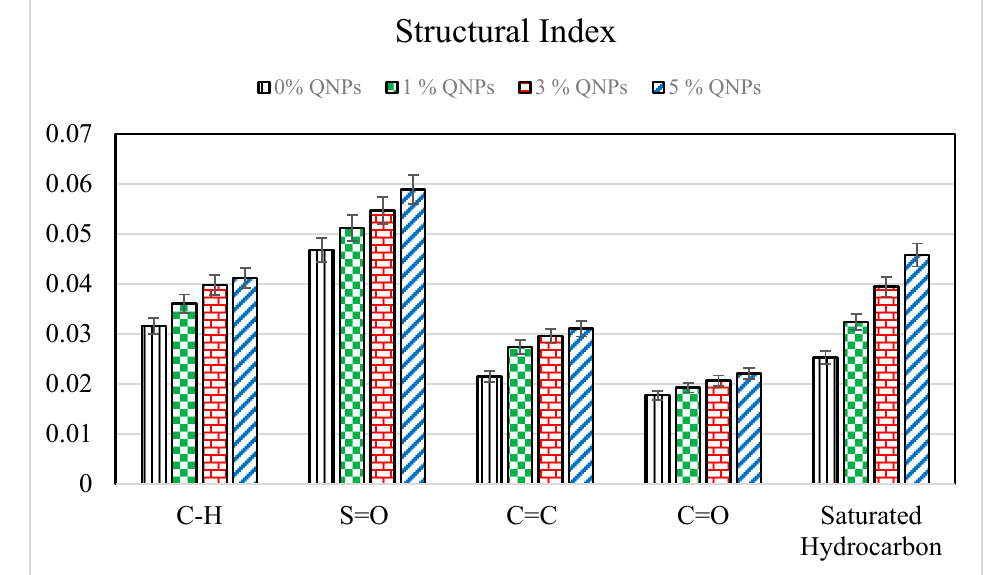
Figure 7. Structural index.